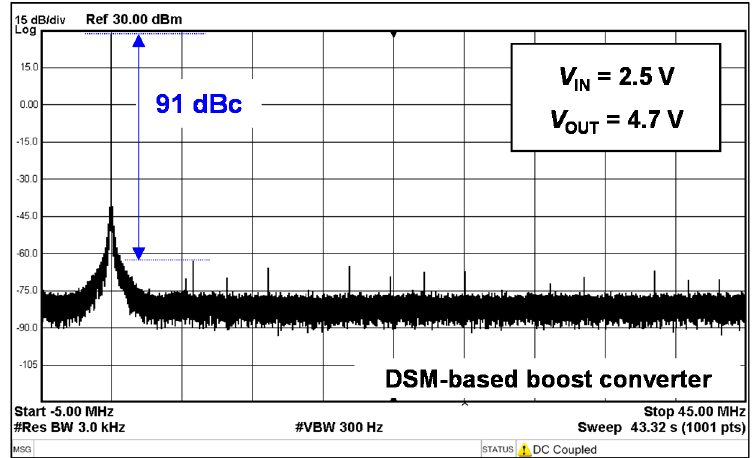
Figure 10. Measured dynamic output voltage scaling.